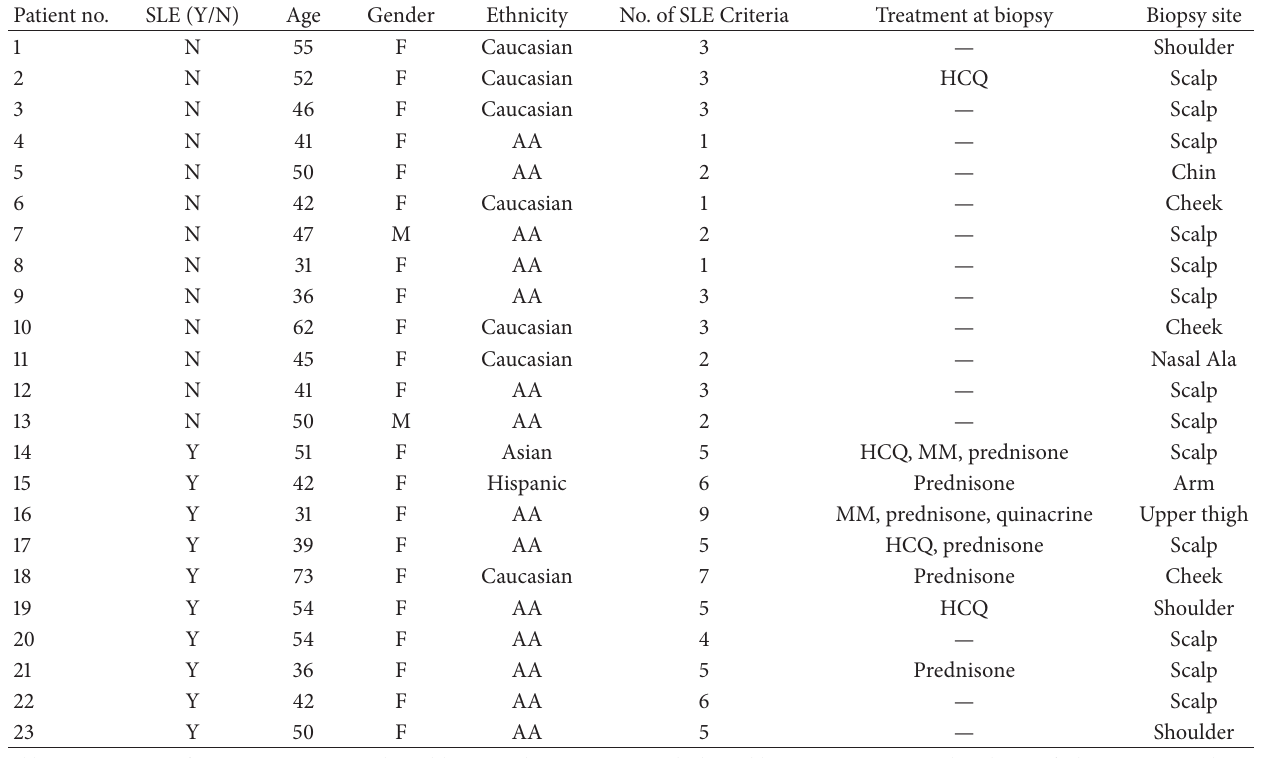
Table 1: DLE patient characteristics.